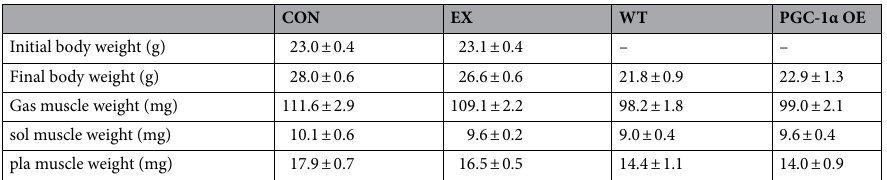
Table 1. Body and muscle weights. Data are expressed as mean ± SEM. n = 7 in the CON and EX groups. n = 5 in the WT and PGC-1α OE groups. gas gastrocnemius, sol soleus, pla